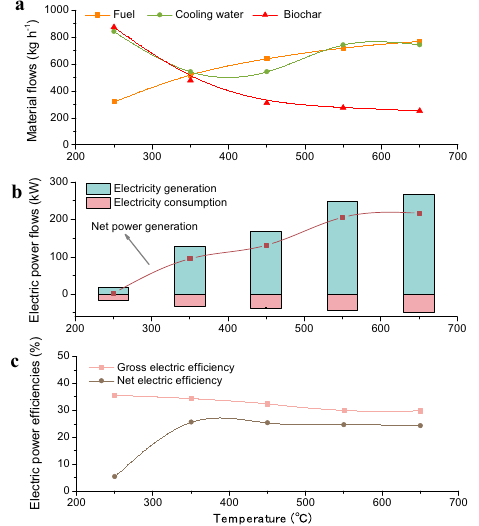
Fig. 1 Performance of a BIPP system with temperature varying from 250 to 650 °C for 1 t biomass input per hour. a Material fl ows: fuels input for high-temperature fl ue gas generation, cooling water inputs used to cool biochar, and the biochar output; b electric power fl ows: electricity generation by the pyrolysis gas combustion power system, electricity consumption of the whole system, and net power generation; c electric power ef fi ciencies: gross/net ef fi ciencies of electricity generation in the BIPP system, which are de fi ned as the gross/net power generation divided by the energy input from pyrolysis